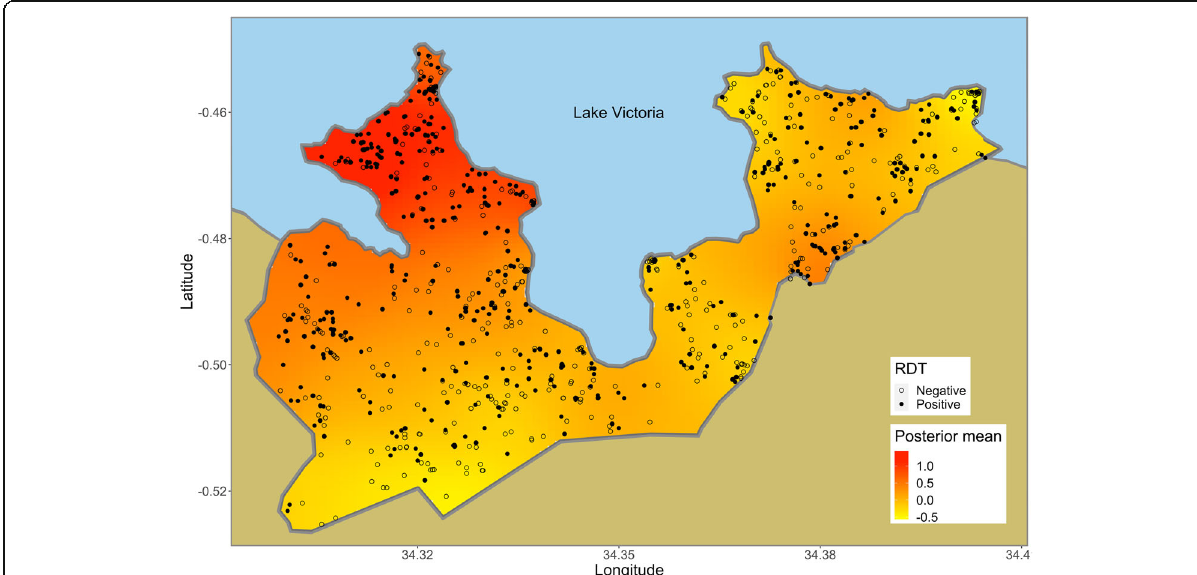
Fig. 3 The interpolated spatial pattern of RDTpfPR. The map was generated with posterior mean values of spatial random field obtained from the Bayesian regression model